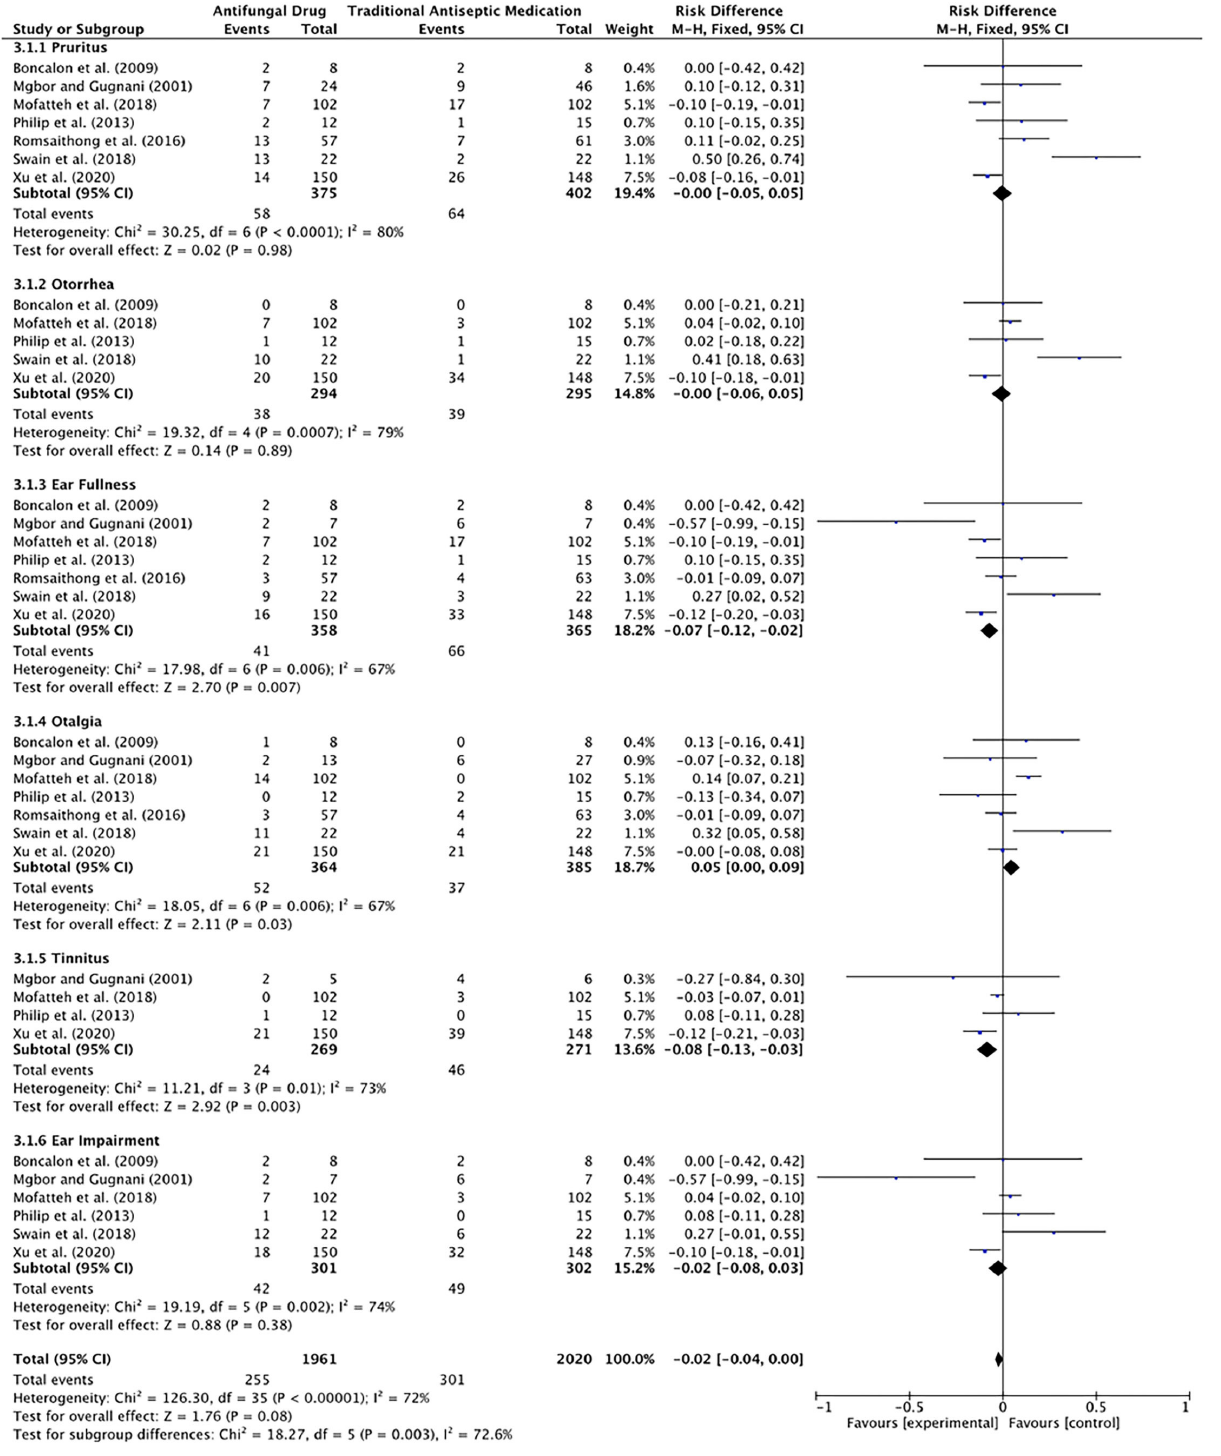
Frontiers in Surgery |